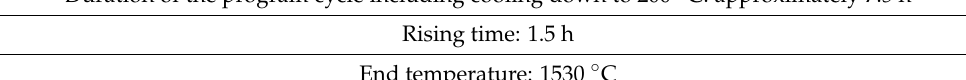
Table 2. Sintering parameters of zirconia specimens. Duration of the program cycle including cooling down to 200 ◦ C: approximately 7.5 h Rising time: 1.5